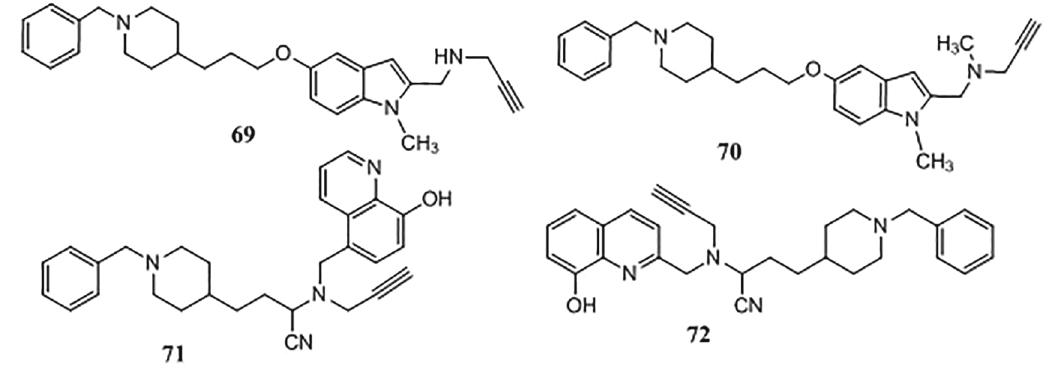
FIGURE 10 - Propargylamine derivatives of